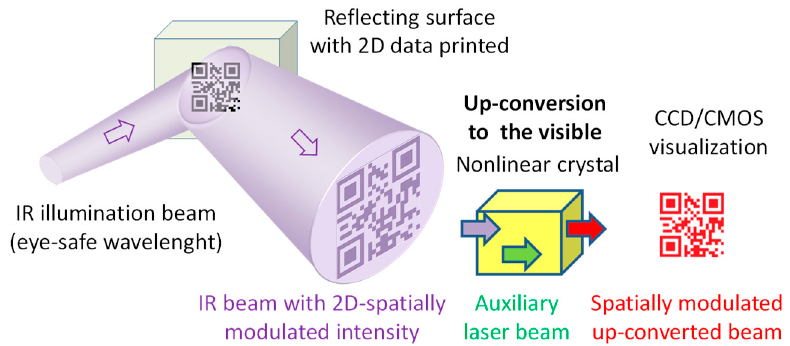
Figure 1. Remote sensing by up ‐ conversion of encoded 2D data from IR (infrared) illumination. CCD/CMOS: charge ‐ coupled and complementary metal ‐ oxide ‐ semiconductor devices.